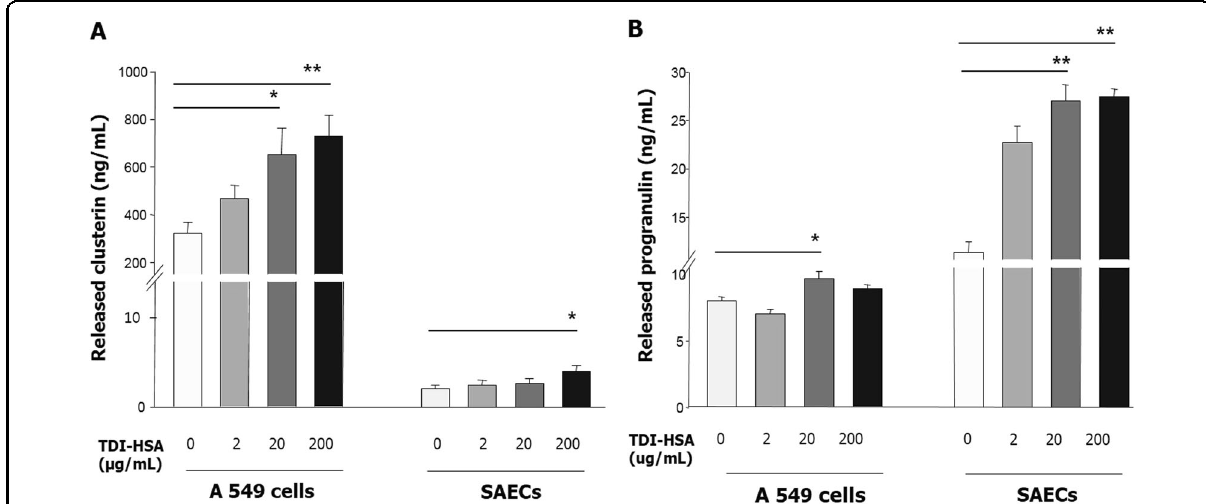
Fig. 3 Clusterin ( a ) and progranulin production ( b ) by human airway epithelial cells after TDI exposure. Two HAECs, A549 cells and SAECs, were seeded (2 × 10 5 cells per mL) into 12-well plates and stimulated with TDI-HSA conjugate (2, 20, and 200 μ g/mL) for 24 h. The clusterin and progranulin released from A549 cells and SAECs were measured by ELISA. Data are presented as the mean ± SEM of duplicate results from at least three independent experiments. * P < 0.05, ** P < 0.001 obtained by one-way ANOVA with LSD post-hoc test. HAECs human airway epithelial cells, TDI-